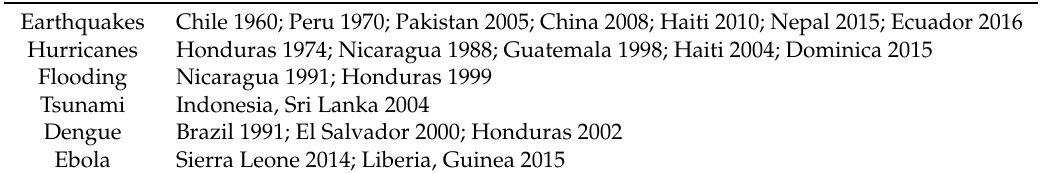
Table 1. Examples of emergency assistance by